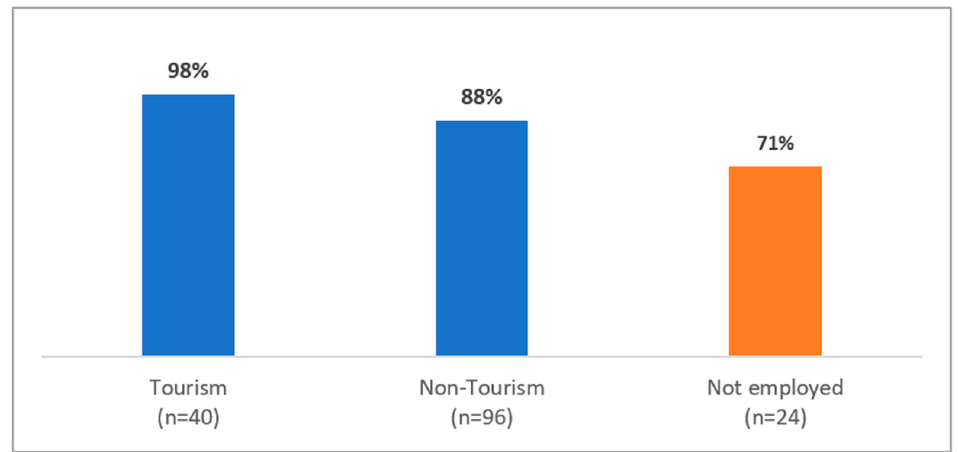
Figure 8. Definitely planning to work over summer/fall by pre-COVID employment.